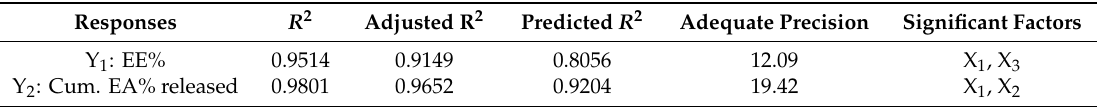
Table 3. Statistical analysis output of response data of the 2 3 factorial design used for the formulation of EA–Ca pectinate